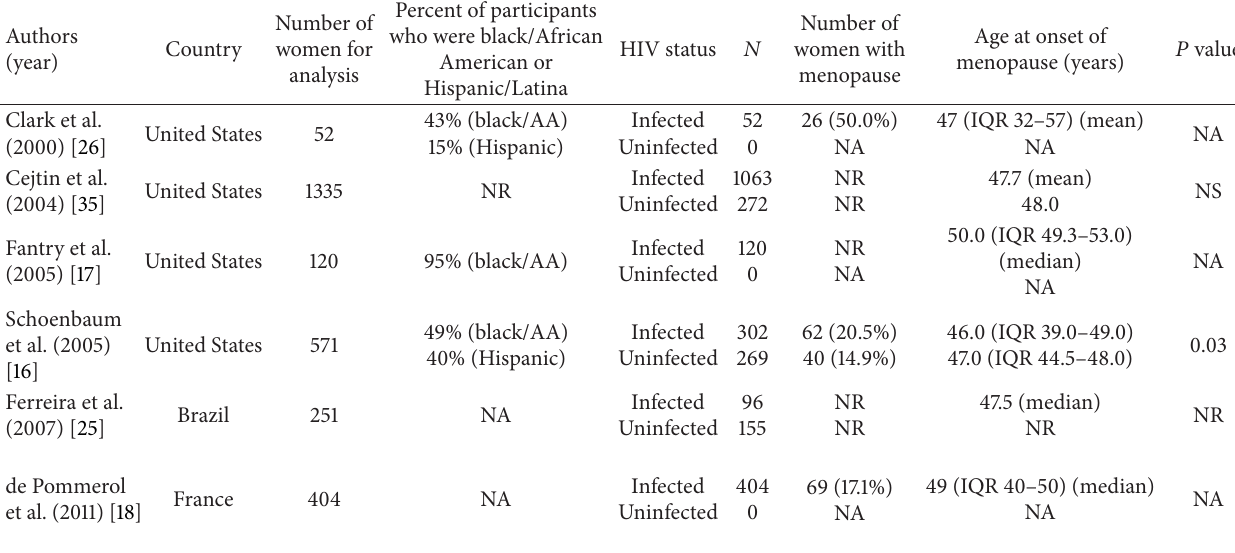
Table 1: Studies available through 2012 evaluating age at menopause in HIV-infected